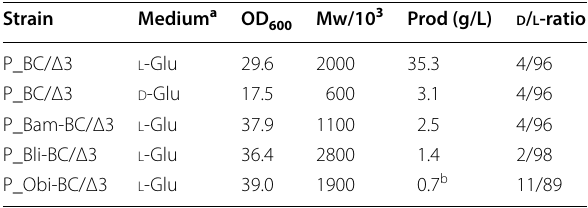
Table 3 Chirality of PGA from